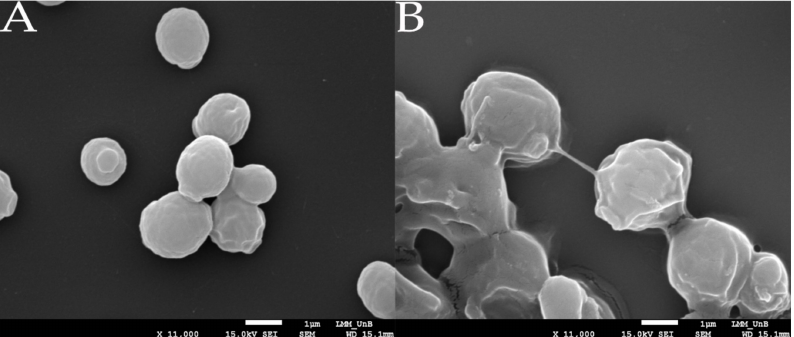
Figure 4. Scanning Electron Microscopy of different O. polymorpha strains. The names above the image correspond to the respective strain. Images were acquired at two magnifications: ( A ) 2000 × and ( B ) 5500 × .